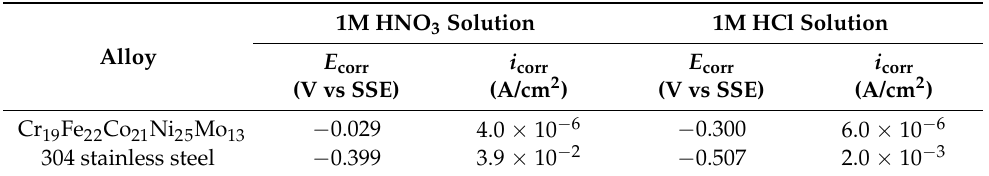
Figure 3. Polarization curves of Cr 19 Fe 22 Co 21 Ni 25 Mo 13 alloy and 304 stainless steel tested in the deaerated solutions of: ( a ) 1M HNO 3 solution and ( b ) 1M HCl solution at 30 °C. Table 3. Corrosion potentials and corrosion current densities of Cr 19 Fe 22 Co 21 Ni 25 Mo 13 alloy and 304 stainless steel tested at 30 °C.